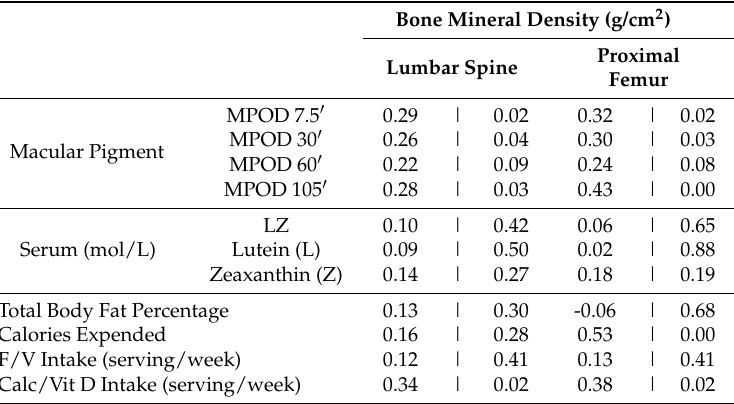
Table 2. Pearson-product moment correlation coefficients and significance values ( r | p ) for associations between bone mineral density, LZ status, body fat, and health